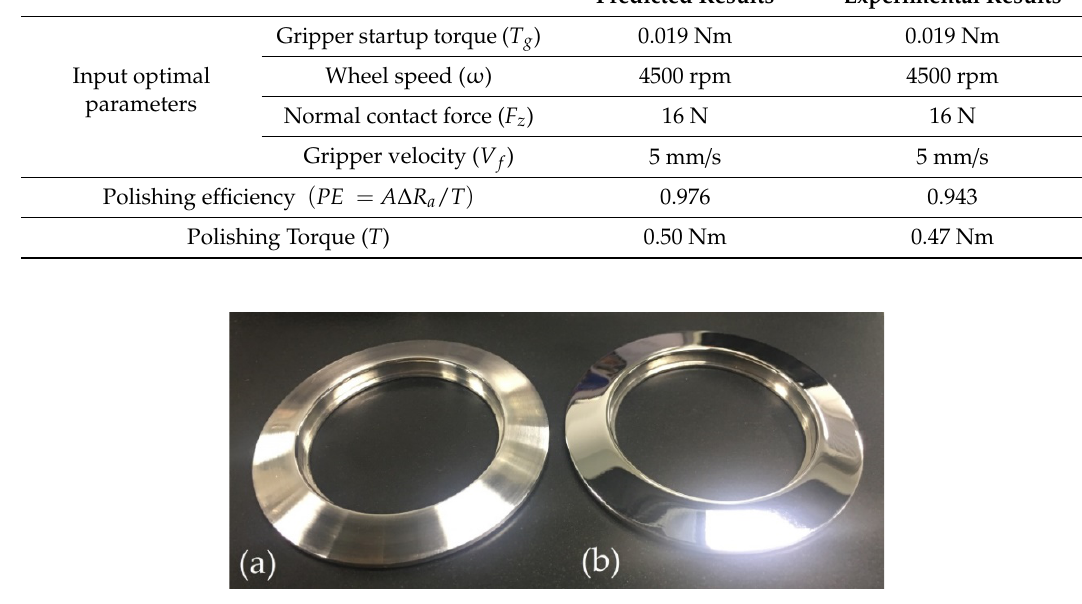
Table 8. Conformation test results for the optimal polishing parameters.